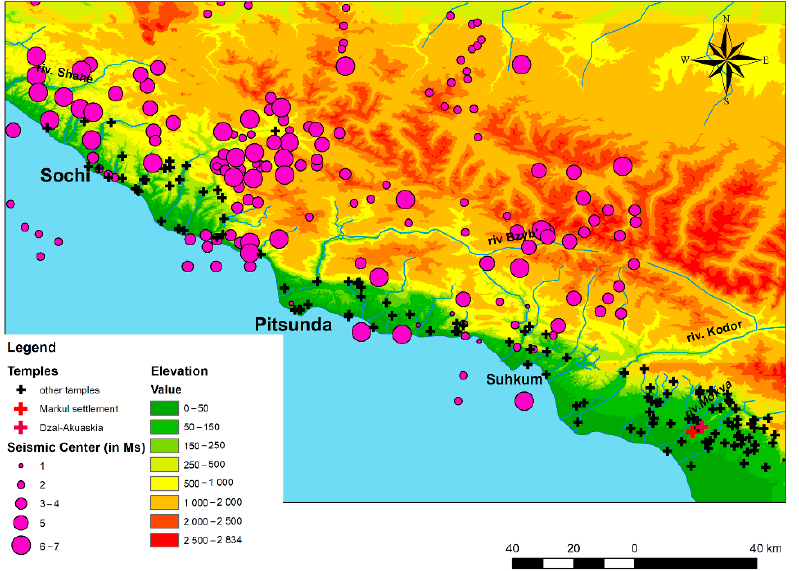
Figure 4. A map of earthquake centers (pink circles) recorded by our team (data from the centers are taken from [32]) and the Markul settlement (red cross), where multiple traces of earthquakes and landslides were recorded after our expedition’s excavations.